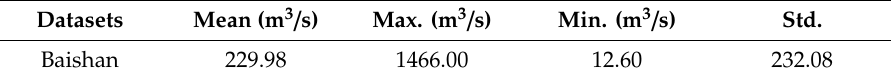
Figure 5. Runo ff series collected from Baishan Hydropower Station. Figure 5. Runoff series collected from Baishan Hydropower Station. Figure 5. Runoff series collected from Baishan Hydropower Station. Table 1. Statistical information of the collected runo ff Table 1. Statistical information of the collected runoff series. Table 1. Statistical information of the collected runoff series.